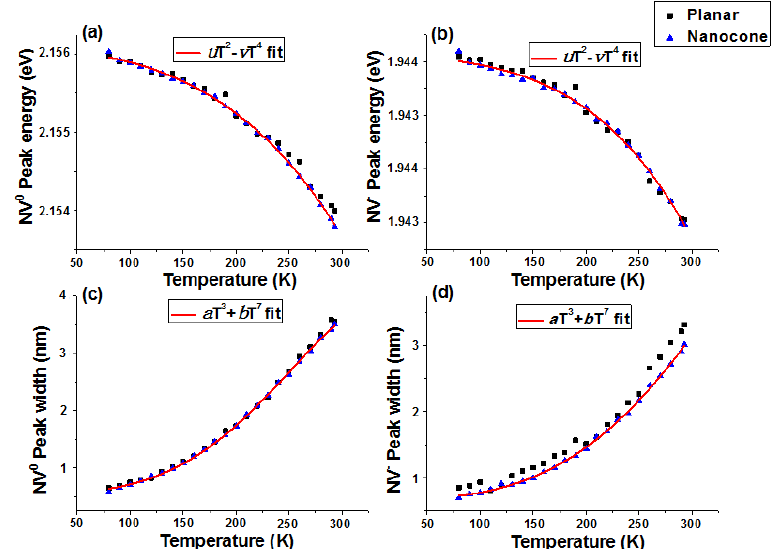
Figure 6. Photo energy and peak width of N-V 0 ( a , c ) and N-V − ( b , d ) peaks at various temperatures. The redlines are fitting data for N-V center peak energy and width, respectively.